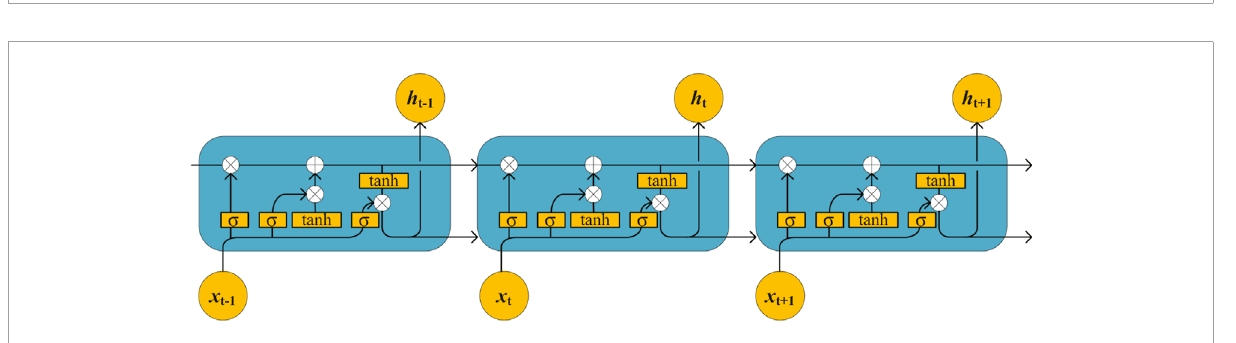
FIGURE 3 The chain of LSTM neural